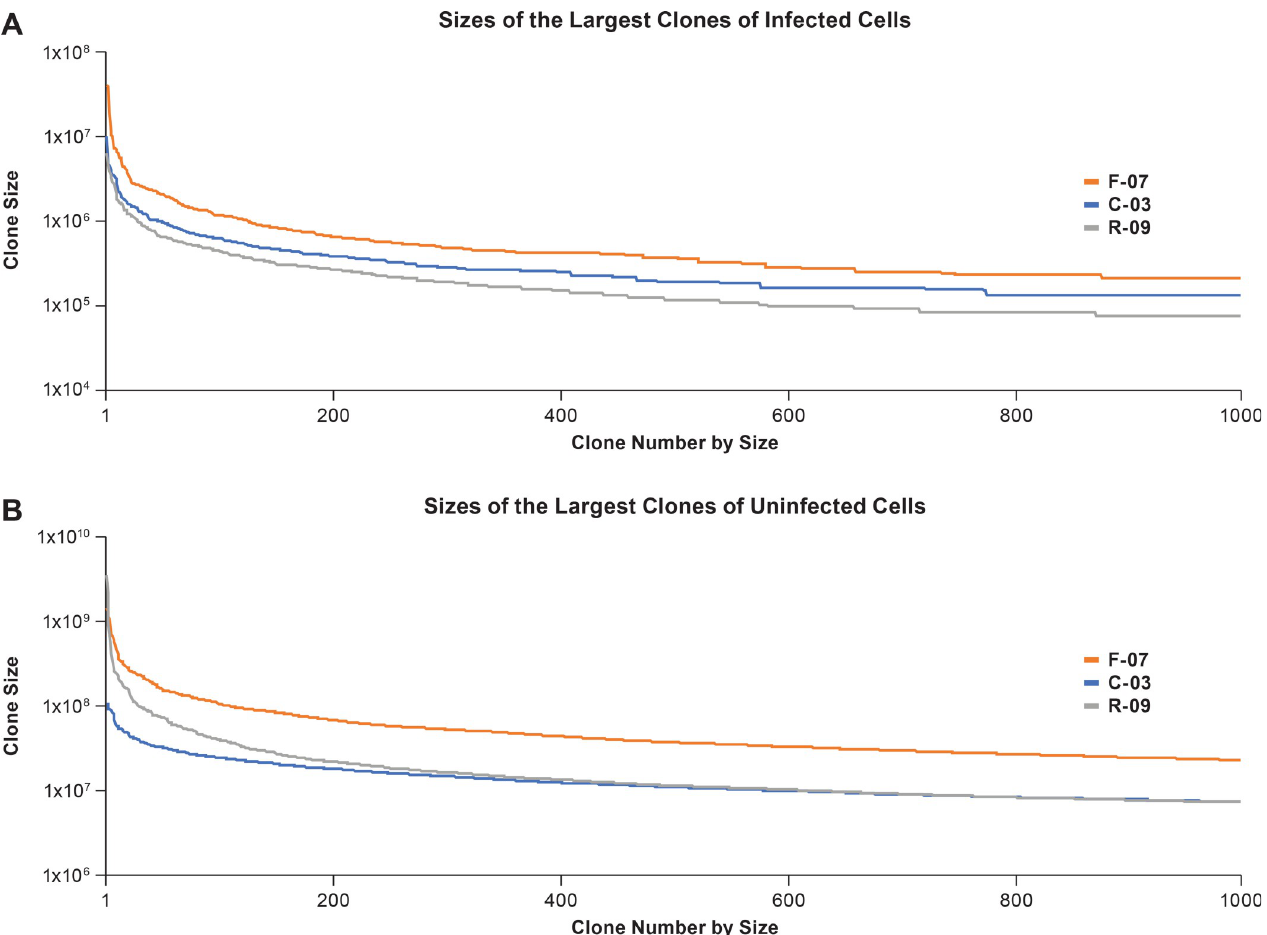
Fig 1. Sizes of the largest clones of infected and uninfected clones of CD4+ T cells in the three donors. The sizes of the largest clones of infected cells were determined using the integration site data (available on the HIV DRP RID). The actual sizes of the individual clones were calculated based on the counts of CD4+ T cells for each of the donors, the fraction of the CD4+ T cells that were infected, and the fraction of the infected cells in each clone. Similarly, the sizes of the uninfected clones were calculated based on the number of CD4+ T cells, and the fraction of the total recovered TCR sequences that were obtained for each clone (see Methods). The clone sizes shown in the figures were determined by combining, for each of the donors, the data obtained from all the time points.